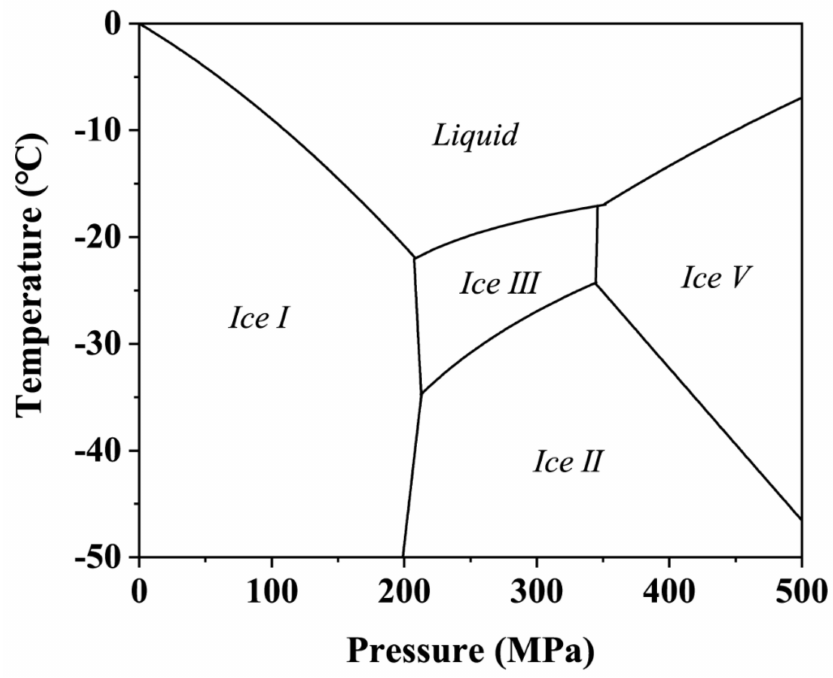
Figure 1. Phase diagram of pure water under high pressure based on data reported by Bridgman